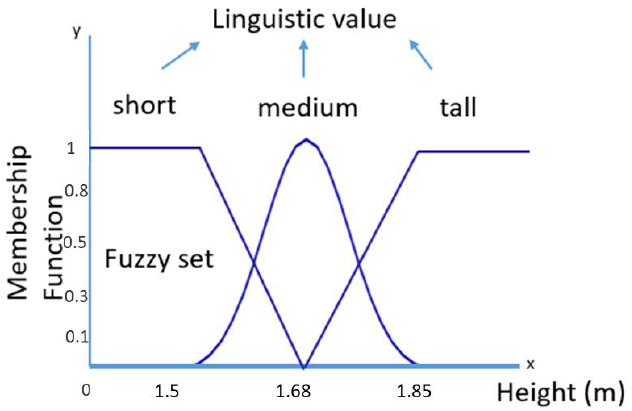
Figure 1. Fuzzy set representation.